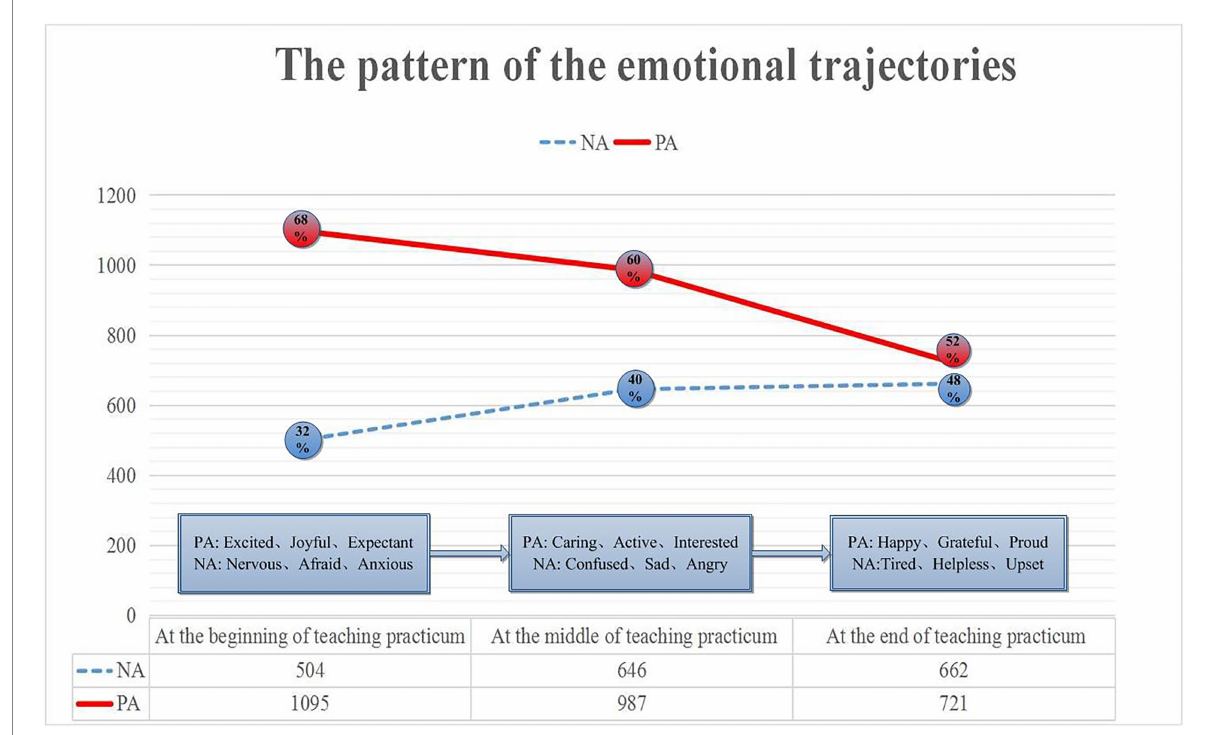
FIGURE 3 Emotional trajectory pattern of pre-service teachers in the process of teaching practice.